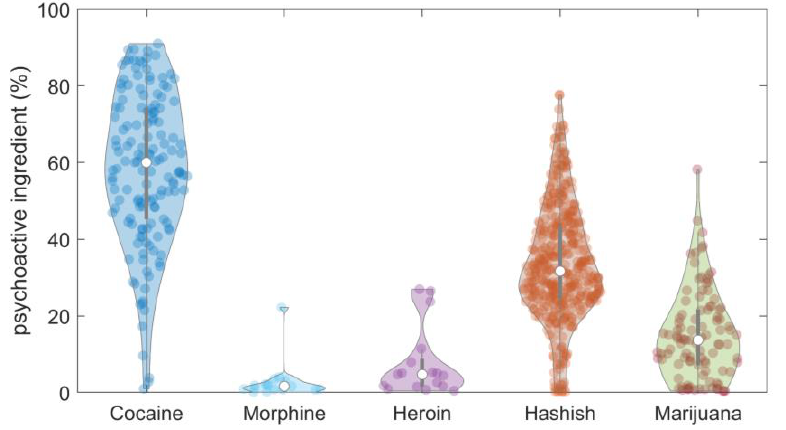
Figure 4. Violin plot of psychoactive ingredient (%) for the most frequent types of street seizures.